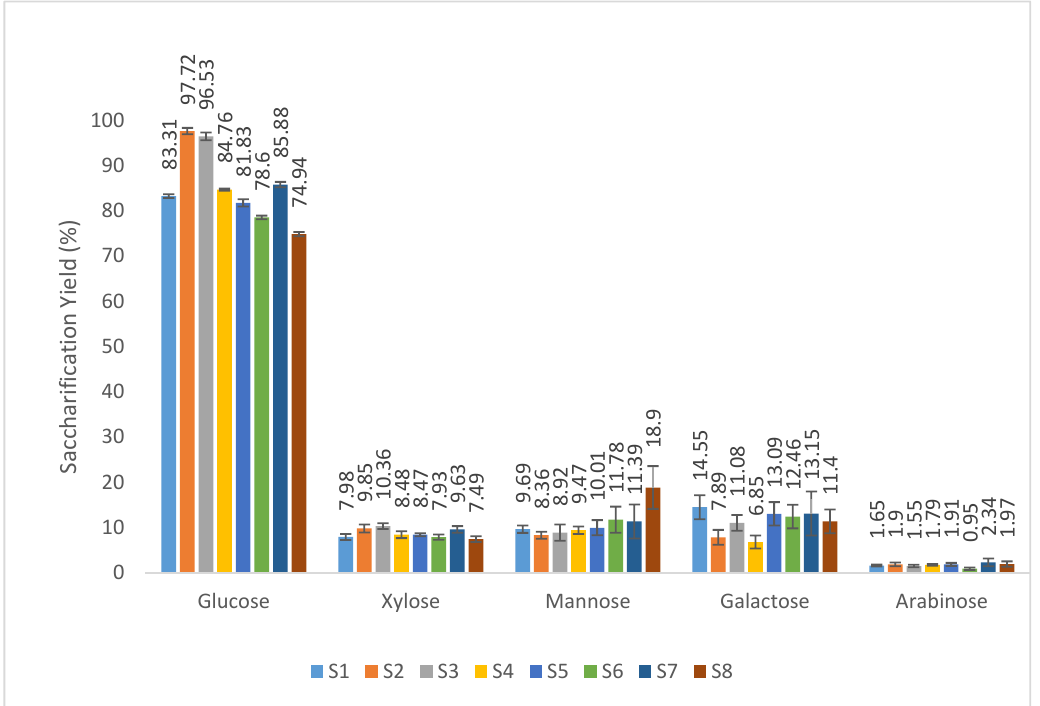
Figure 2. Saccharification yield in pulp.